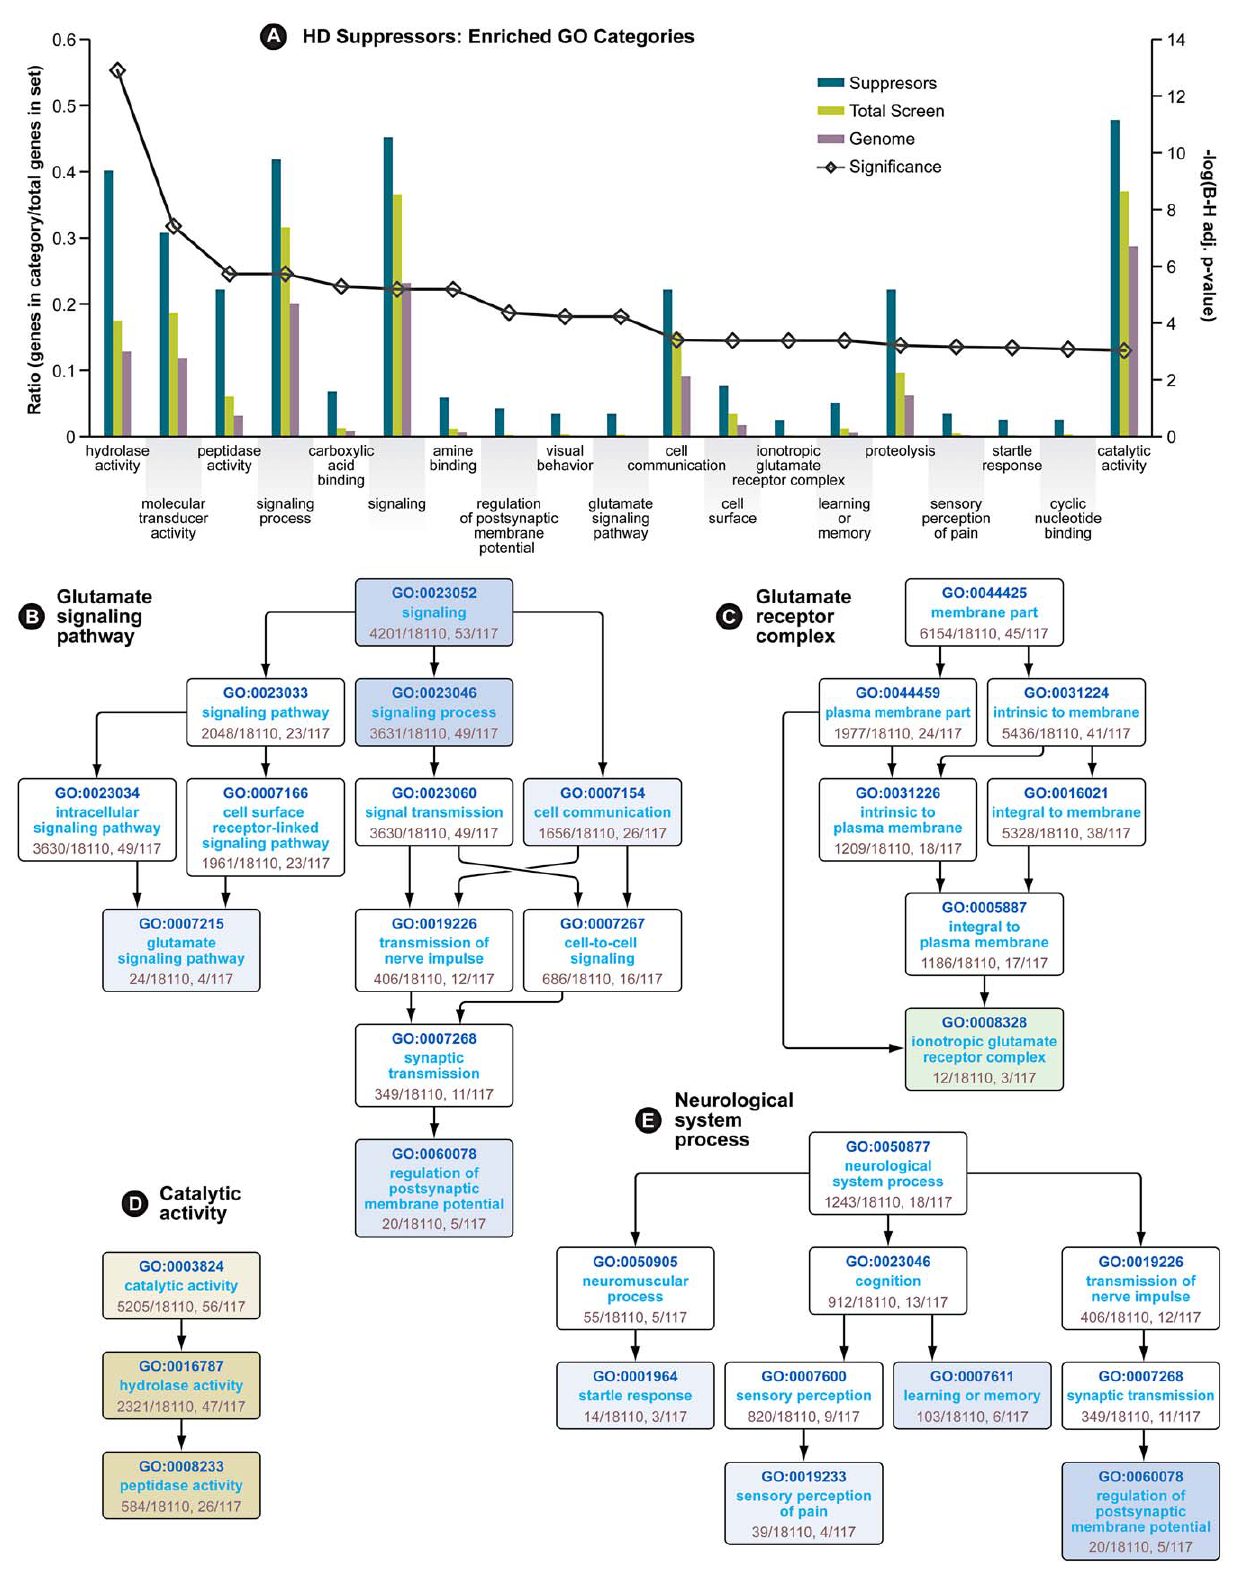
Figure 1. Gene Ontology Enrichment Analysis of HD Suppressors. (A) Enriched GO categories for HD suppressor genes. Significance (line with open diamonds) is represented as the 2 log(Benjamini-Hochberg adjusted p-value), and is scaled on the secondary axis. The remaining bars represent the ratio of genes in each category vs. genes in each dataset. (B) Directed Acyclic Graph (DAG) of Glutamate Signaling Pathway GO